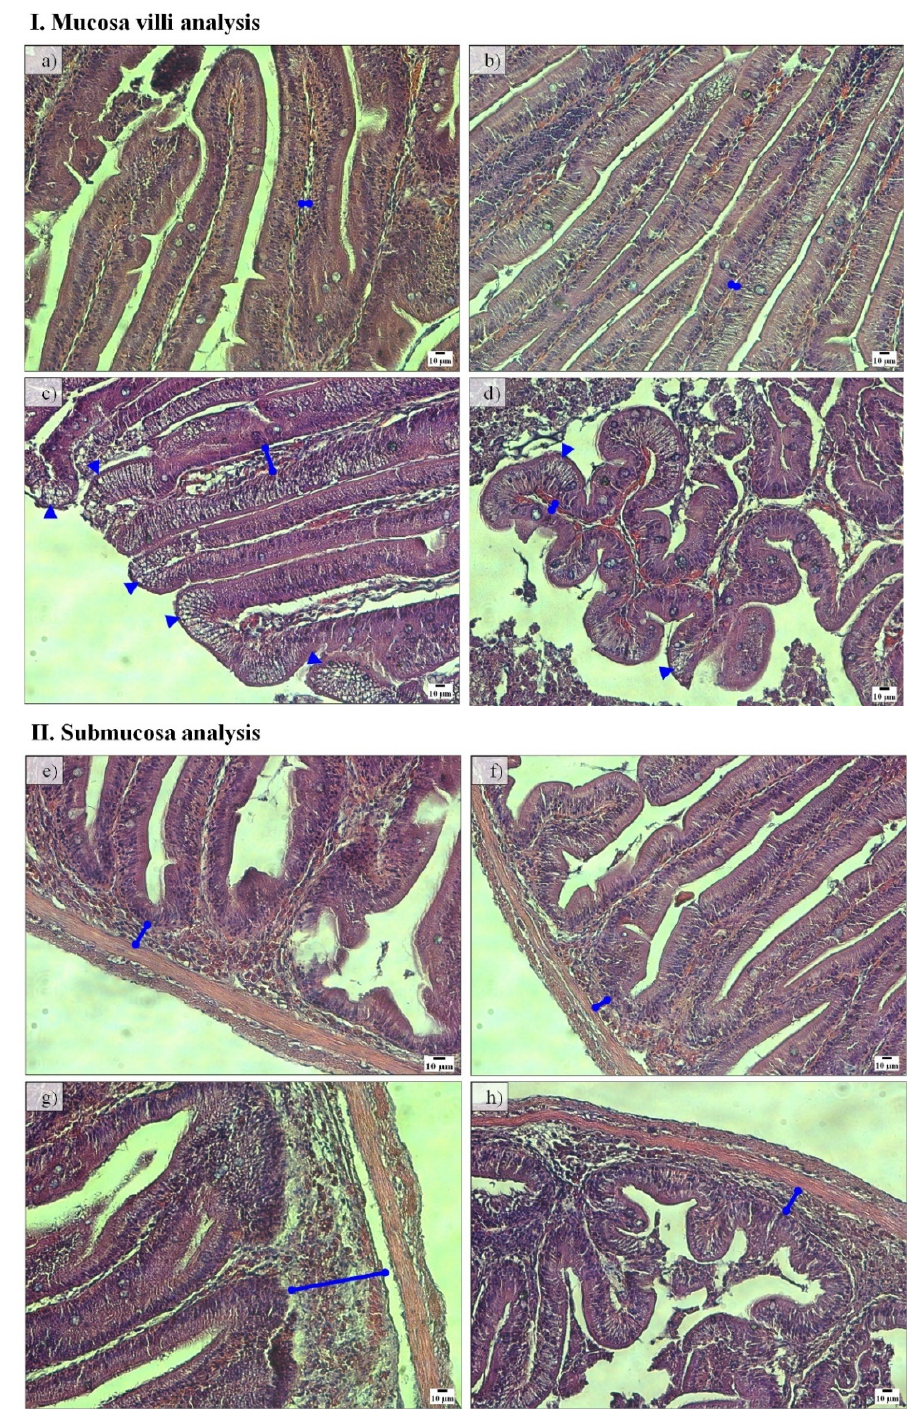
Figure 2. Representative histological sections of pyloric caeca mucosa villi ( I ) and submucosa ( II ) stained with hematoxylin and eosin of fish fed FM-P50/CH10 ( a , e ), FM-P40/CH20 ( b , f ), PF- P50/CH10 ( c , g ), and PF-P40/CH20 ( d , h ). ► enterocytes vacuolization. ( I ): Lamina propria width was higher in fish fed the PF-P50/CH10 diet ( c ) than fish fed the FM-based diets ( a , b ). Enterocytes vacu- olization was higher in fish fed the PF-based diets ( c , d ) than those in the remaining conditions ( a , b ). ( II ): Submucosa width was higher in fish fed diet PF-P50/CH10 ( g ), than those in the remaining conditions ( e – h ).